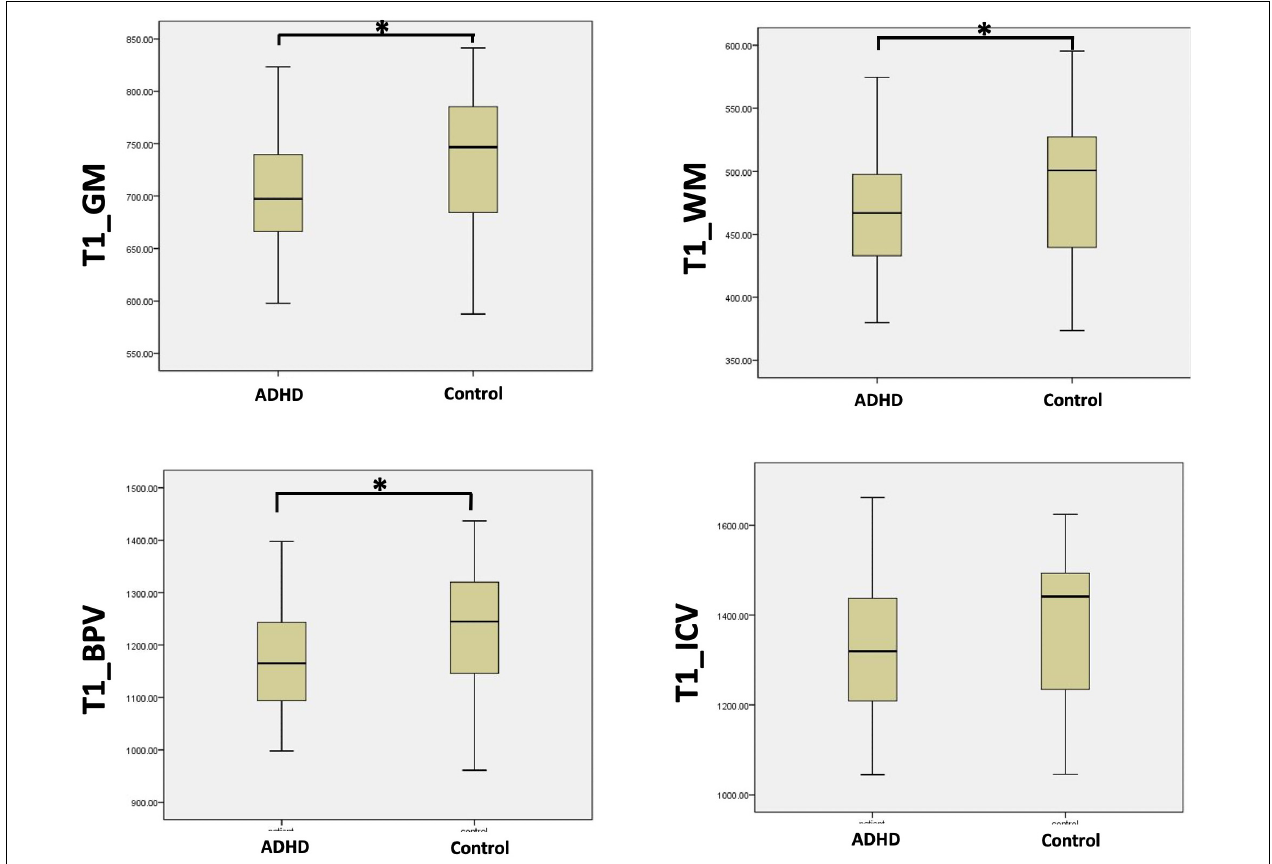
FIGURE 3 | The comparison of the brain tissue volume between ADHD group and control group with the measurements acquired by cT1W images ( ∗ p < 0.05).